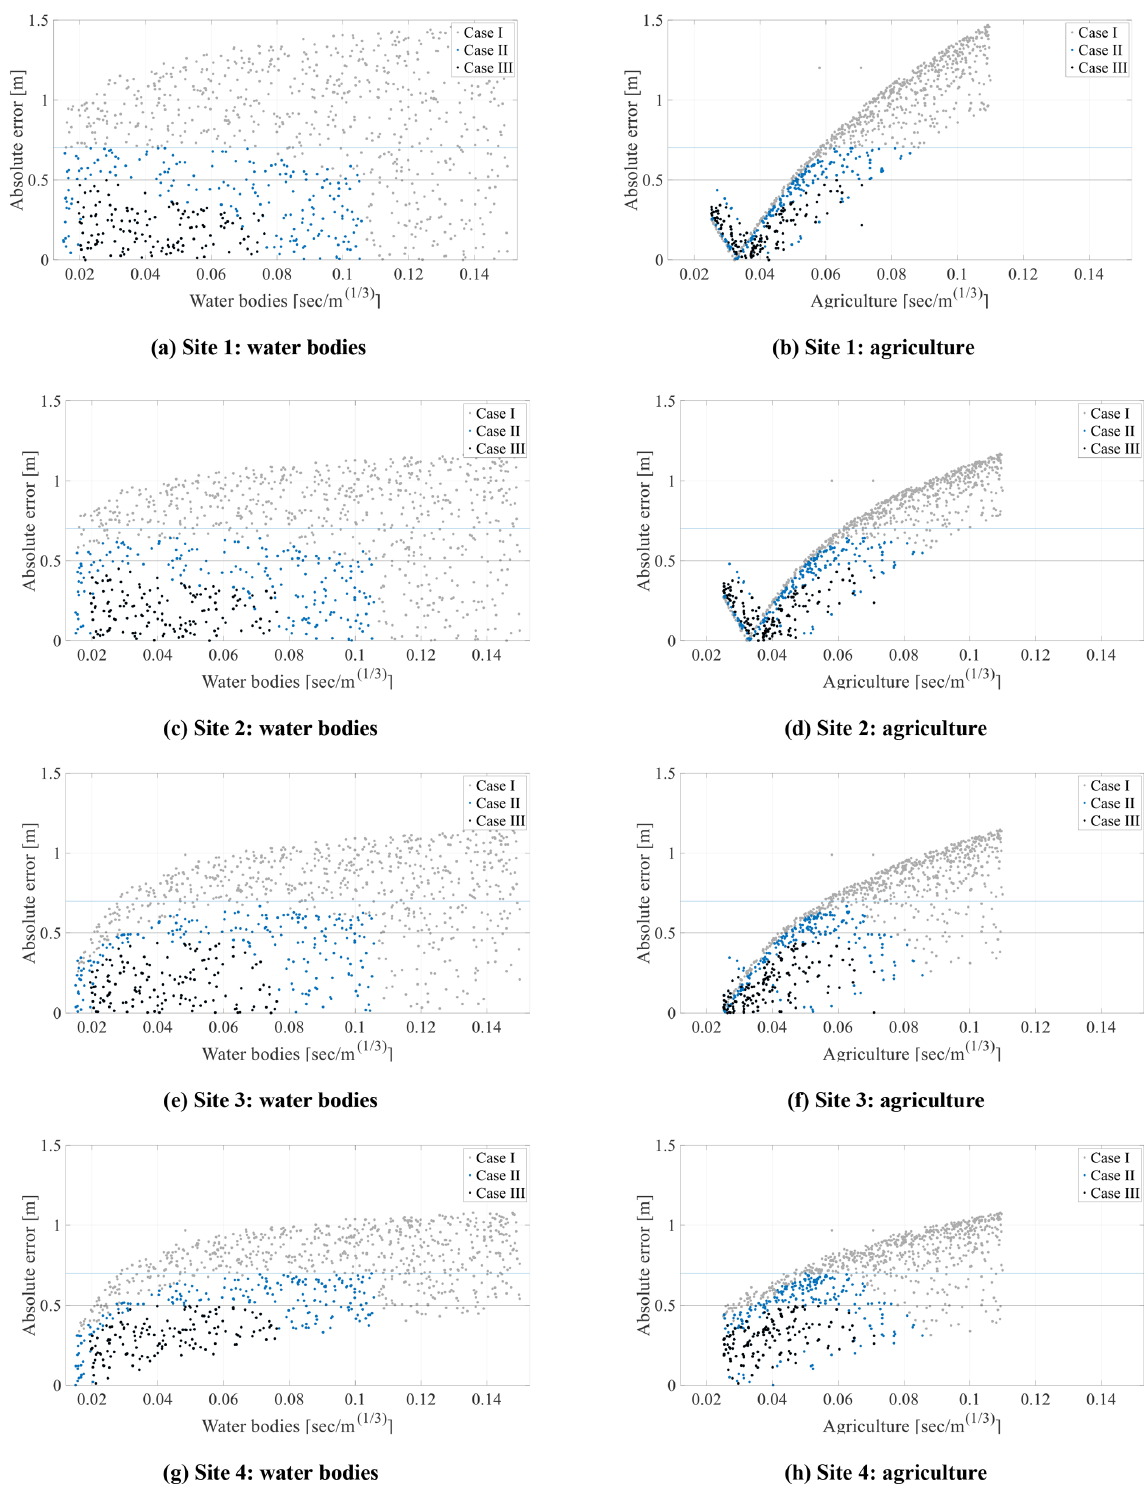
Figure 6. Scatter plot of the absolute error of 1000 simulations in relation to water bodies and agriculture. Cases I, II, and III show accepted simulations based on threshold values of 1.5, 0.7, and 0.5 m